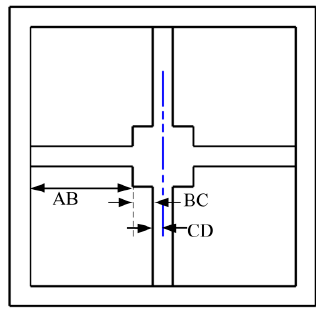
Figure 5. Vertical view of microstructure.